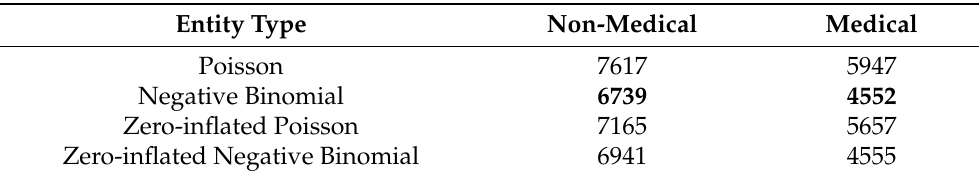
Table 3. Goodness-of-fit